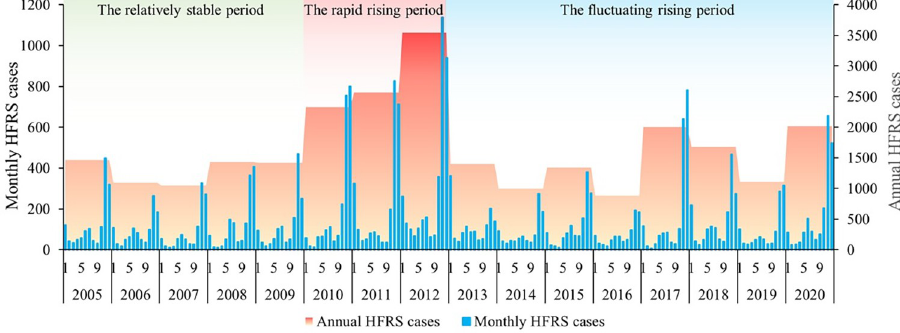
Fig 4. The number of annual and monthly HFRS cases in Weihe Basin of Shaanxi Province from 2005 to